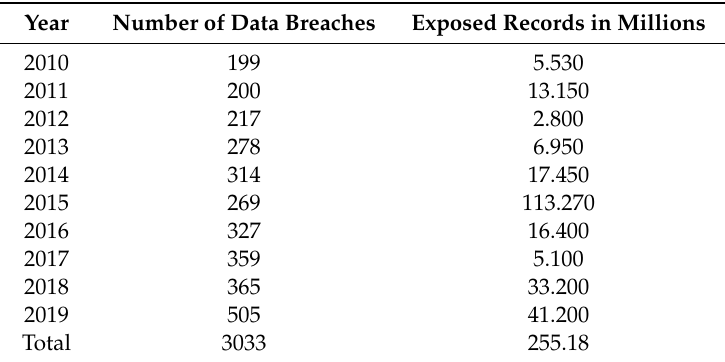
Table 3. HIPAA Reported Healthcare Data Breaches.